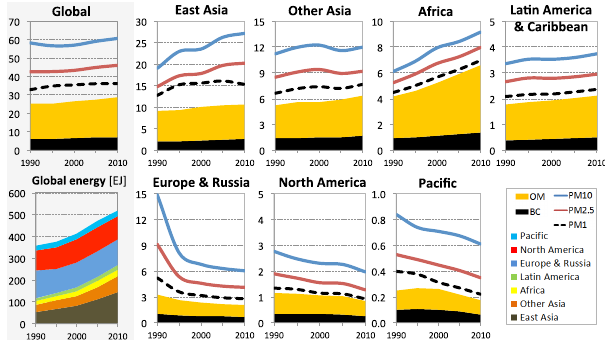
Figure 6. Global and regional emissions of PM species (Tg) and global energy consumption (EJ) in the period 1990–2010, ECLIPSE V5a .